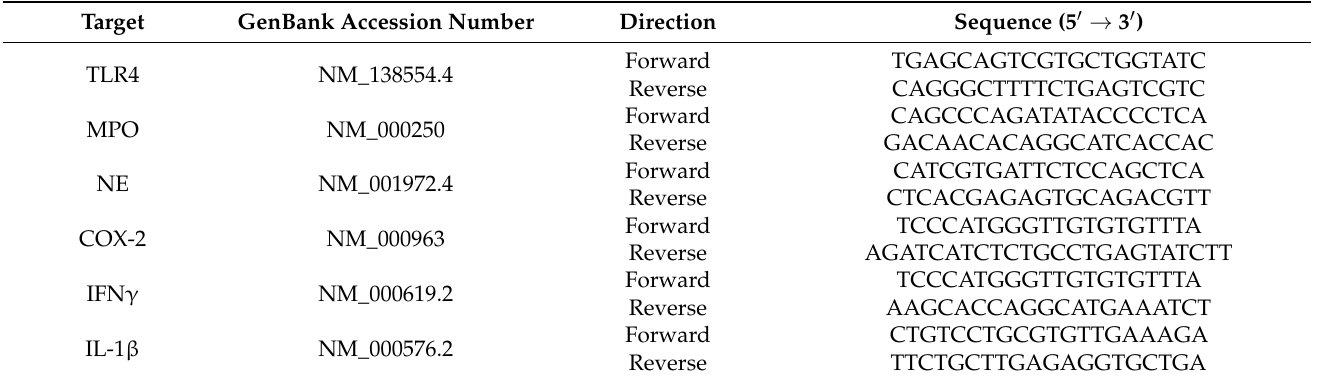
Table 1. Sequences of RT-PCR primers for gene expression